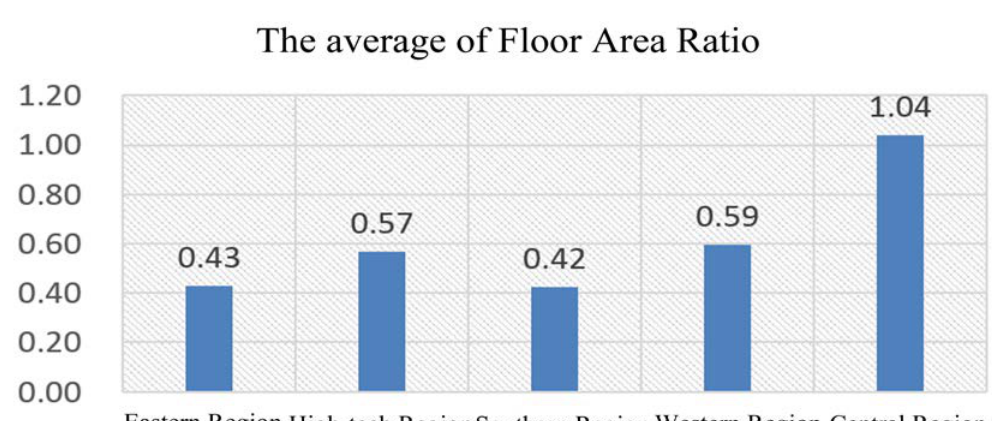
Figure 5. The divisional statistics of floor area